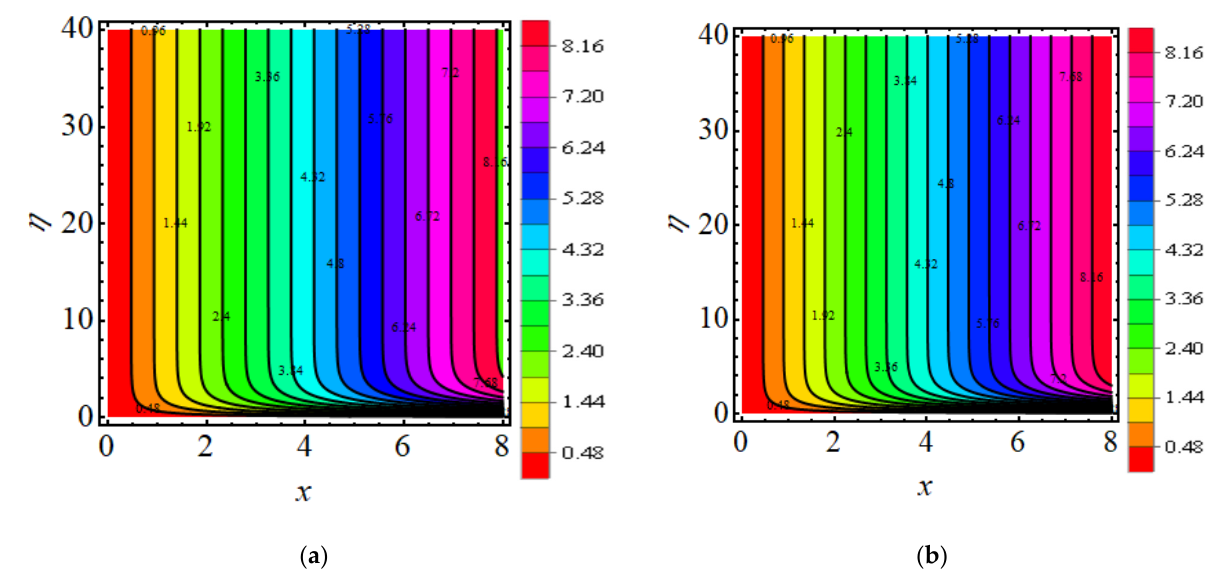
Figure 11. ( a , b ) Streamline for ( a ) β = − 2.5 ( b ) β = 2.5.